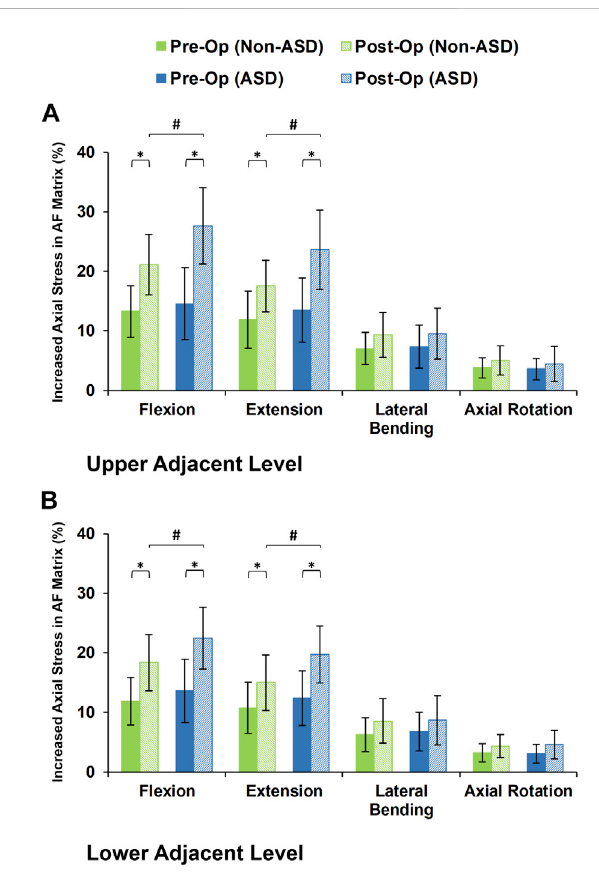
FIGURE 8 Increased axial stress in AF matrix for post-operative non-ASD and ASD group FE models for the (A) upper and (B) lower adjacent levels.